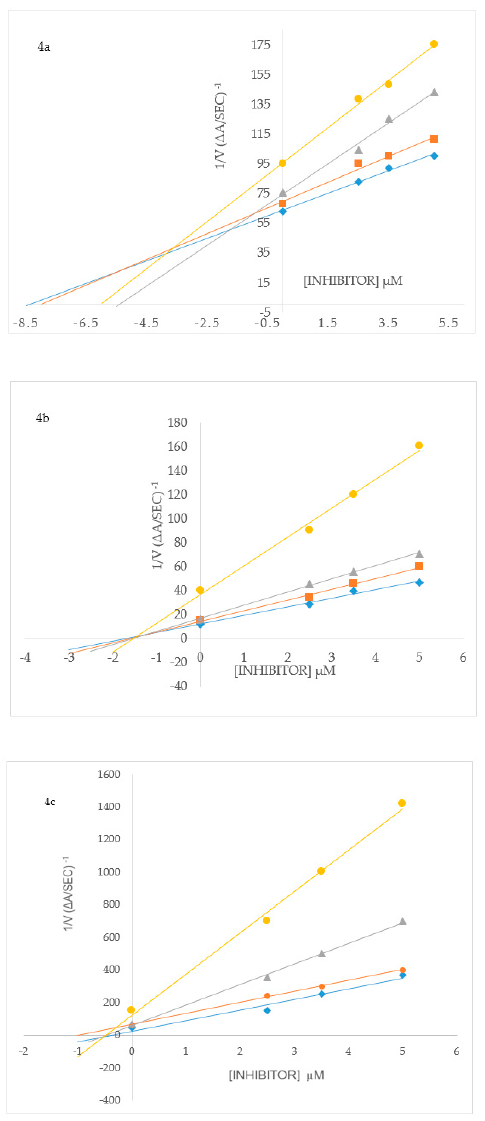
Figure 4. Dixon plots for inhibition of AChE by 3b (Figure 4a) and BChE by 2h (Figure 4b) and 3p (Figure 4c). Blue symbols and fitted straight lines represent enzyme activity with 5 mM substrate, while orange (2.5 mM), grey (0.5 mM) and yellow (0.1 mM) represent various concentrations of substrate.